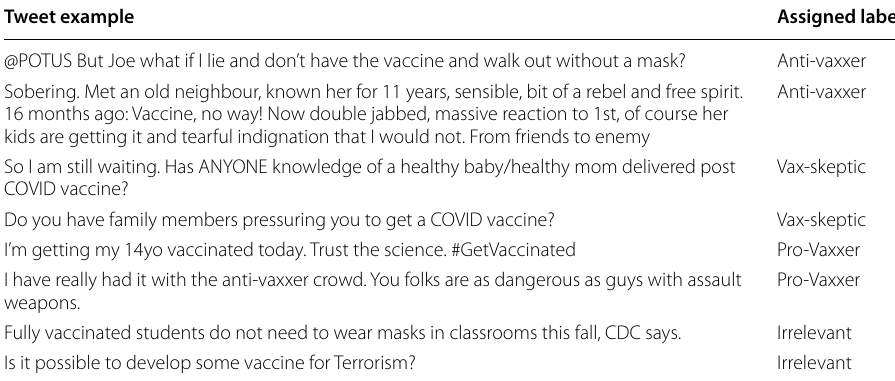
Table 1 Example tweets for different vaccine view categories Tweet example